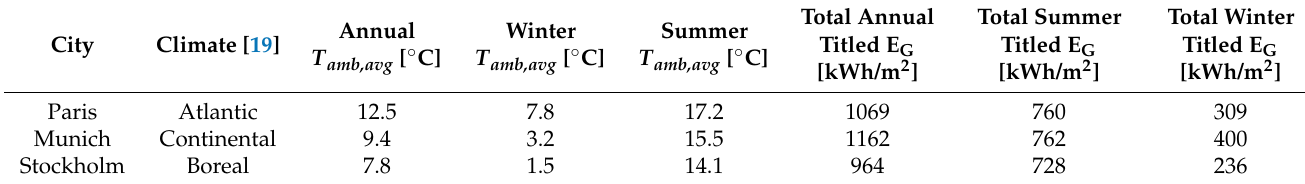
Table 7. GPS coordinates and inclination of solar Table 6. Location and climatic properties of the studied locations.